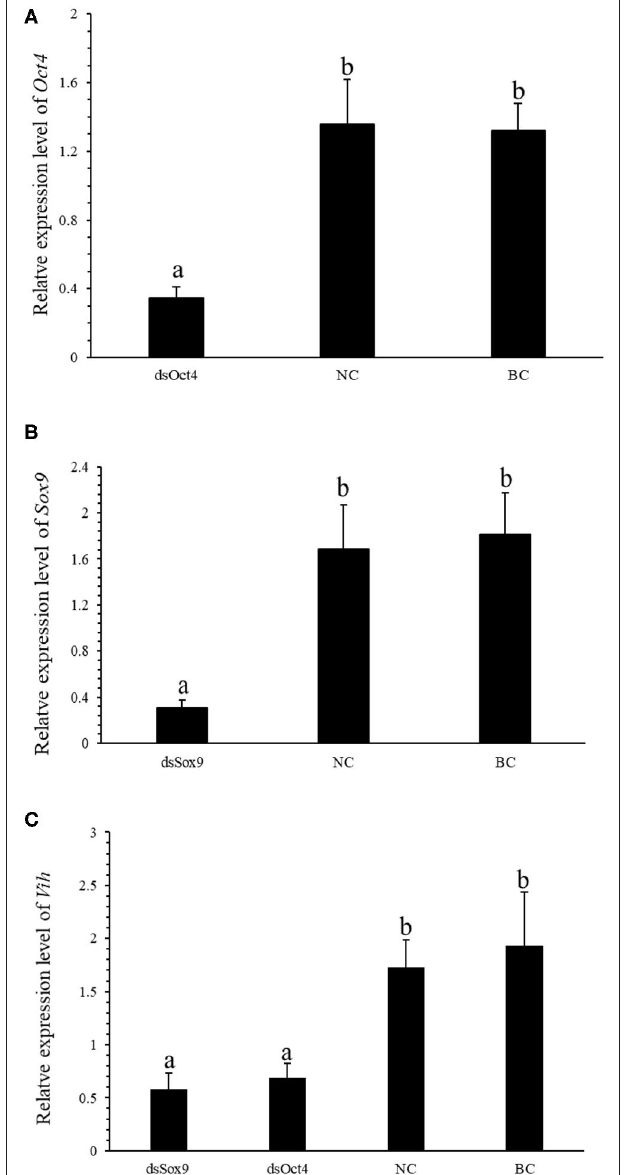
FIGURE 3 | Oct4 or Sox9 RNA interference reduces the expression level of SpVih . (A) Relative expression of Oct4 in the eyestalk after injection of dsOct4, dsEGFP, and SPSS. (B) Relative expression of Sox9 in the eyestalk after injection of dsOct4, dsEGFP, and SPSS. (C) The relative expression of SpVih in the eyestalk after injection of dsSox9, dsOct4, dsEGFP, and SPSS. NC, negative control group; BC, blank control group; Bar with different letters indicates significant differences, P < 0.05.